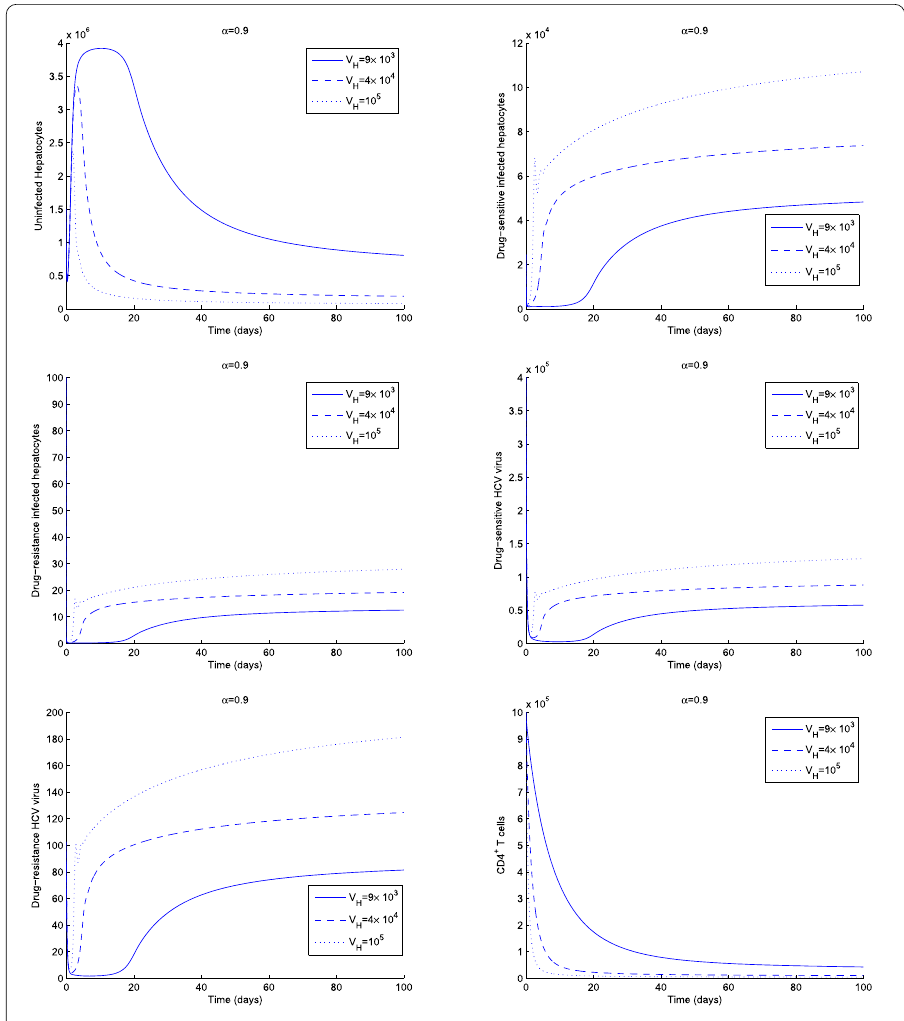
Figure 2 Dynamics of the variables of system (1) for different values of V H , the HIV viral load, and α = 0.9. Parameter values are in Table 1 and initial conditions are in the text.